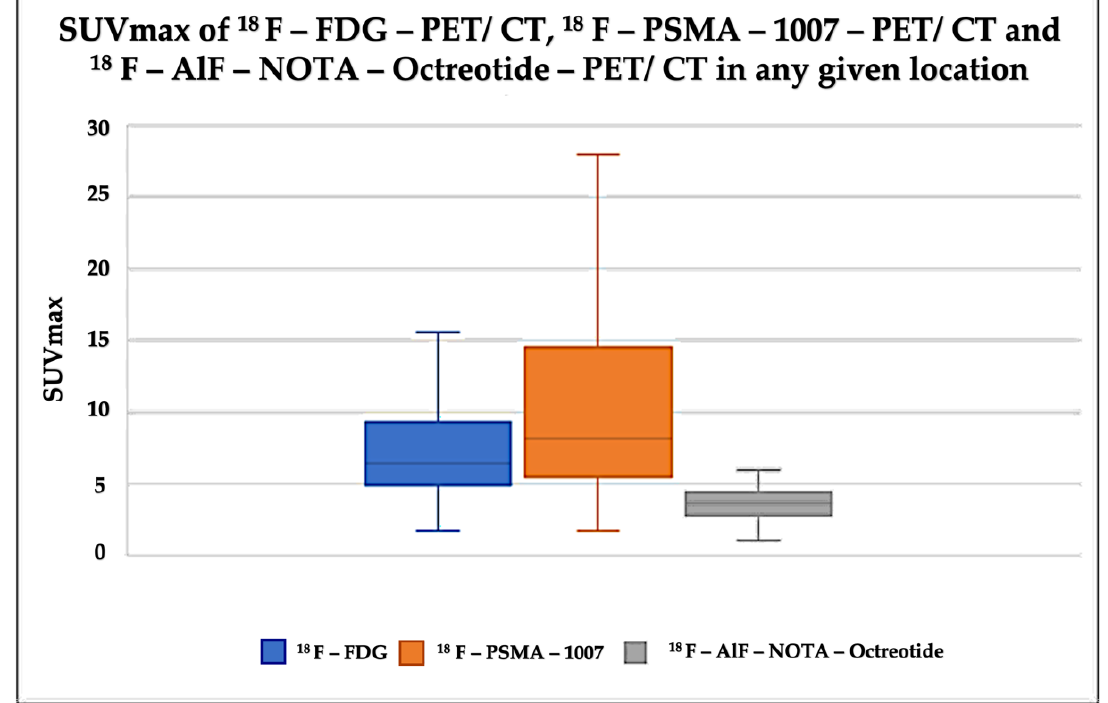
Figure 9. Box-plot diagram of SUVmax in the different radiopharmaceuticals.